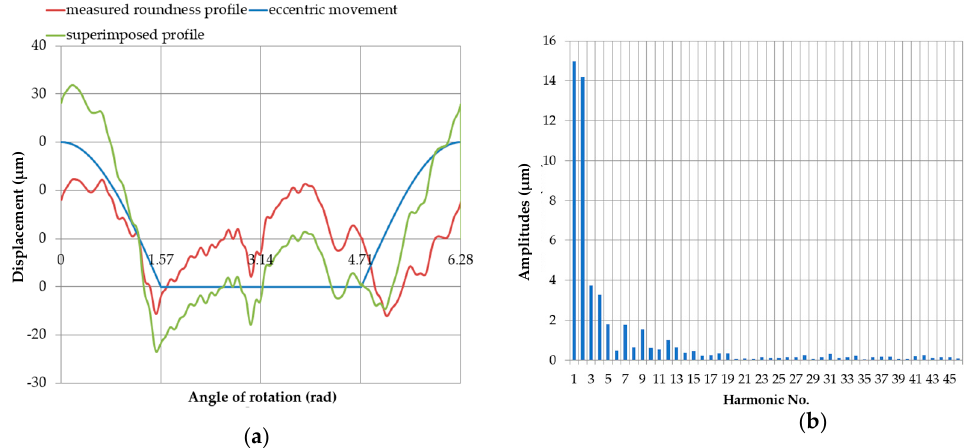
Figure 23. Profile obtained by superimposing the measured roundness profile of journal no. 5 (green)—rotated by 90 ◦ with respect to the reference profile—onto the eccentric movement profile of the center of the measured roundness profile (blue), with the supports set at the same height ( x = 0 mm), with an eccentricity of the main journal e = 0.03 mm ( a ); discrete amplitude spectrum of the superimposed profile ( b ). Table 9. Amplitudes of the harmonic components for the profile obtained by superimposing the measured roundness profile of journal no. 5—and by rotating it by 60 ◦ with respect to the reference profile—onto the eccentric movement profile of the center of the measured roundness profile when the supports were set at the same height ( x = 0 mm), with an eccentricity of the main journal e = 0.03 mm. Harmonic Amplitudes [ µ m]